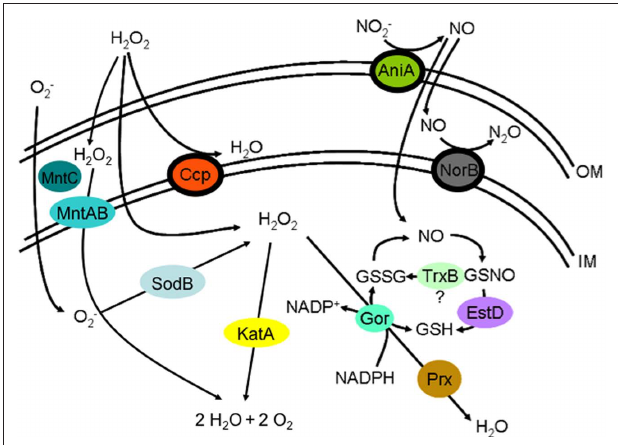
Figure 3 | The following is an illustration of the oxidative stress defenses present in N. gonorrhoeae . The outer membrane is designated OM, while the inner membrane is designated IM. The space between the two membranes is the periplasm, and the space below the IM is the cytoplasm. Reactive oxygen and nitrogen species and their intermediates are designated as follows: O , superoxide; H O , hydrogen peroxide; NO , nitrite; NO, nitric 2 - 2 2 2 - oxide; N O, nitrous oxide; H O, water; O , oxygen; GSSG, reduced glutathione; 2 2 2 GSH, glutathione; GSNO, S -nitrosoglutathione; NAPD + , nicotinamide adenine dinucleotide phosphate; NADPH, reduced nicotinamide adenine dinucleotide phosphate. Proteins that catalyze reactions in the oxidative stress pathways are represented as colored ovals and are placed in the positions where they are located in the cell. The arrows denote reactions, and the proteins that catalyze these reactions are placed near or on the appropriate arrows. These proteins are designated as follows: MntABC, manganese ABC transporter; KatA, catalase; SodB, superoxide dismutase; Ccp, cytochrome c peroxidase; NorB, nitric oxide reductase; AniA, nitrite reductase; EstD, esterase D; TrxB, thioredoxin oxidase; Gor, glutathione reductase;